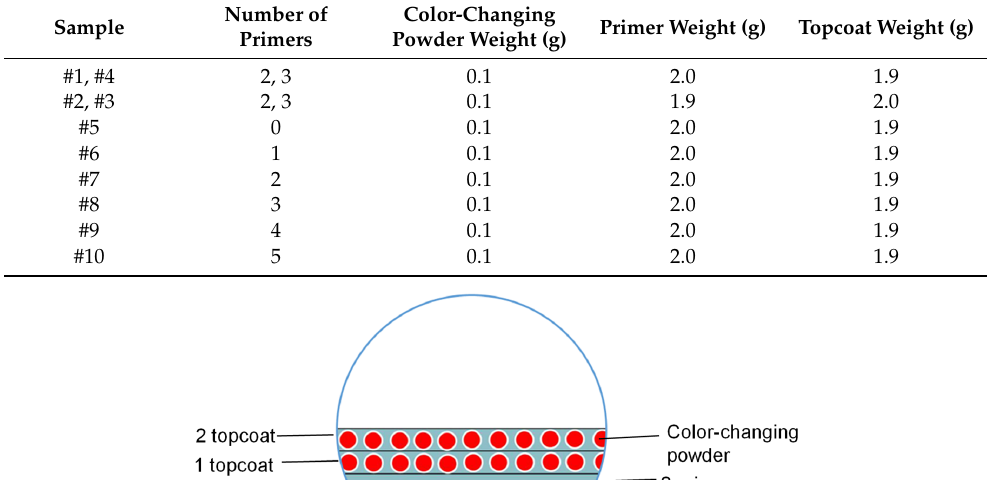
Table 2. Ingredient list of the paint film.